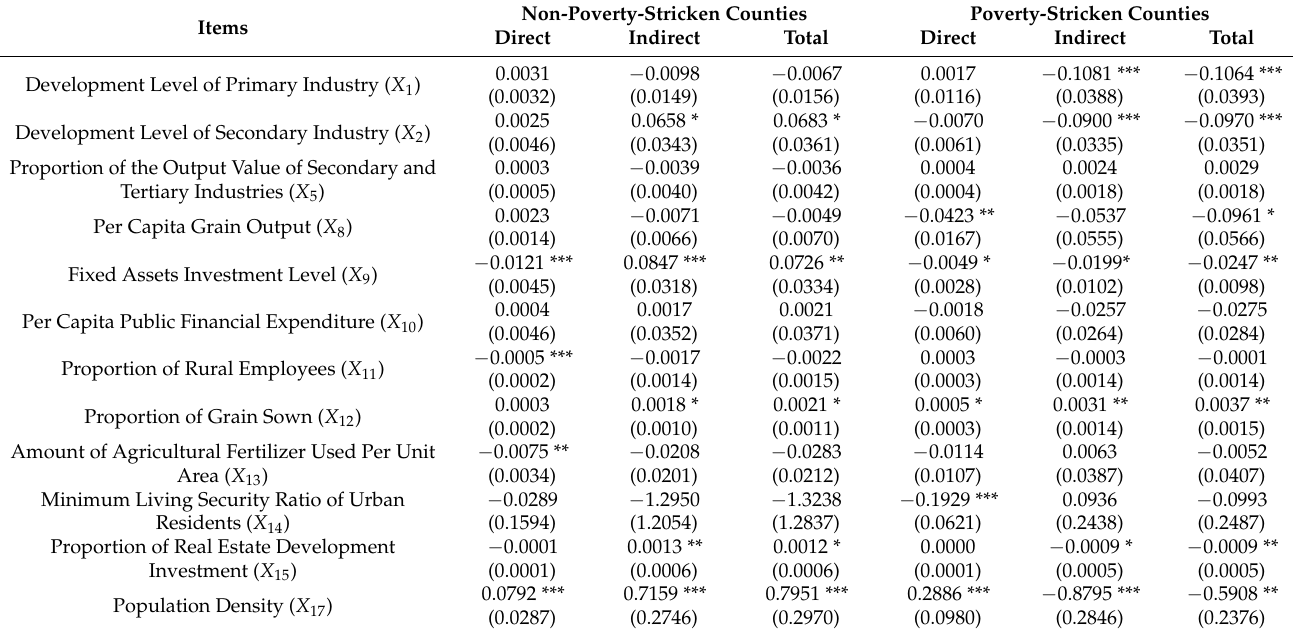
Table 4. Estimation results of the econometric model for the analysis of the spillover effect of the urban–rural income